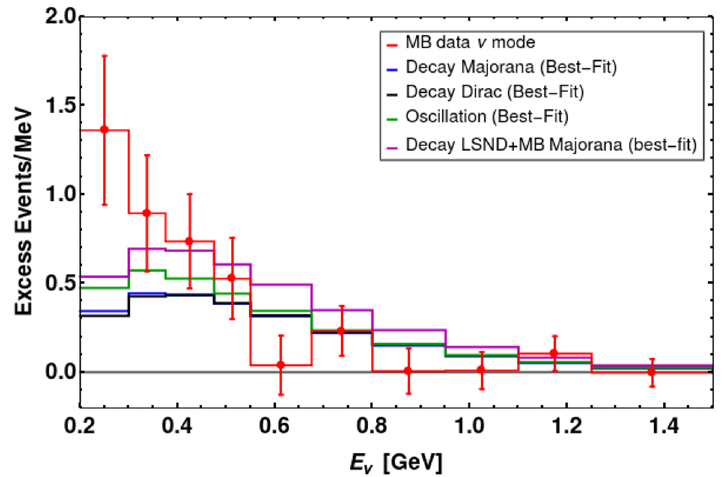
Figure 3 . Best-(cid:12)t (cid:23) e spectra at MiniBooNE, neutrino-mode, as a function of E (cid:23) for the oscillation hypothesis and for the di(cid:11)erent decaying-sterile-neutrino scenarios discussed here. The data points are from the MiniBooNE collaboration report, presented in ref. [3]. The last bin corresponding to [1 : 5 ; 3 : 0] GeV is not shown